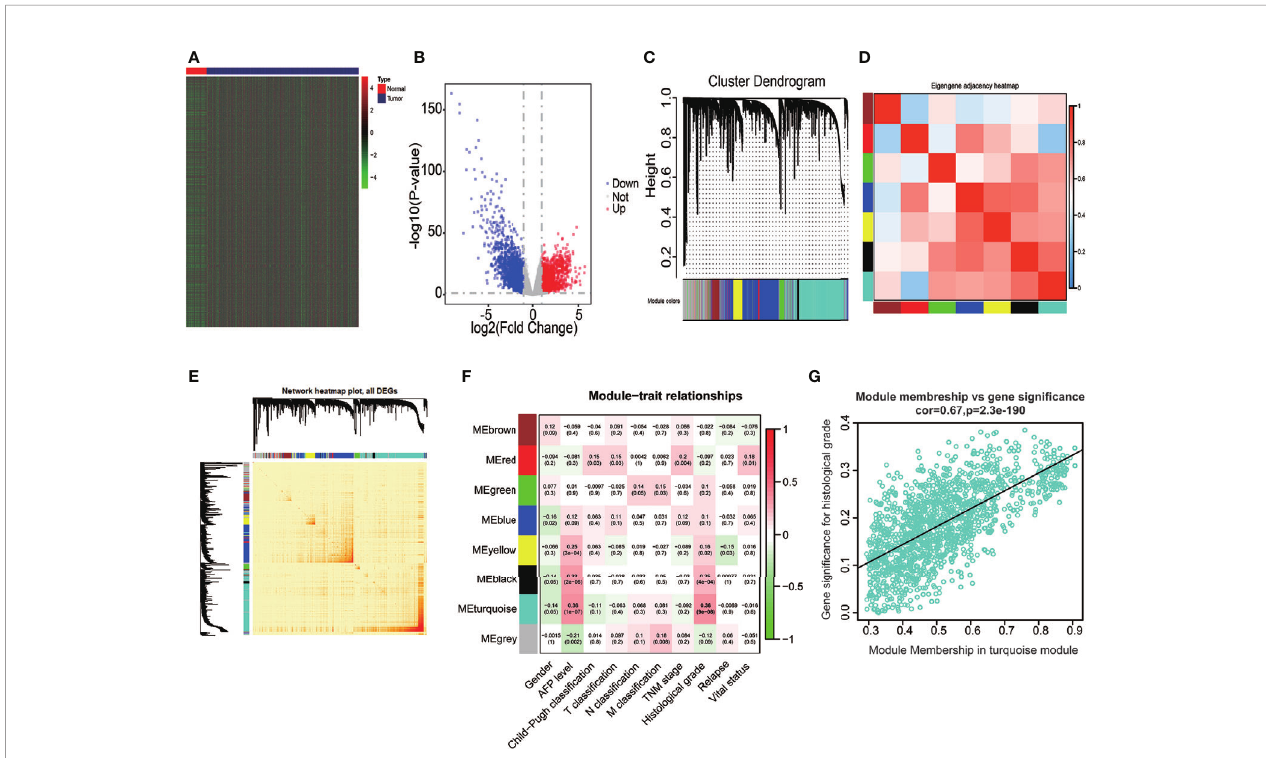
FIGURE 2 | Bioinformatic analysis of HCC samples and matched normal adjacent tissues extracted from the TCGA dataset. (A, B) The heatmap and volcano plot of 4,344 DEGs between 374 HCC and 50 normal tissues. (C) Gene dendrogram of DEGs clustering and module screening according to mRNA expression pro fi les. (D, E) Heatmap of the correlation coef fi cient in the modules. (F) Correlations of module eigengenes and a series of clinical traits. (G) Analogous scatter plots for the turquoise module. DEGs, differently expressed